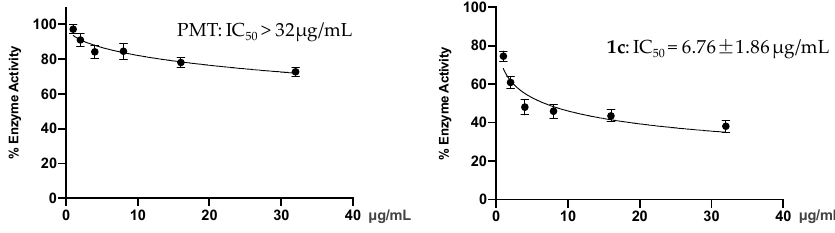
Figure 3. Effects of Palmatine (PMT) and 1c on the activity of Jack bean urease.